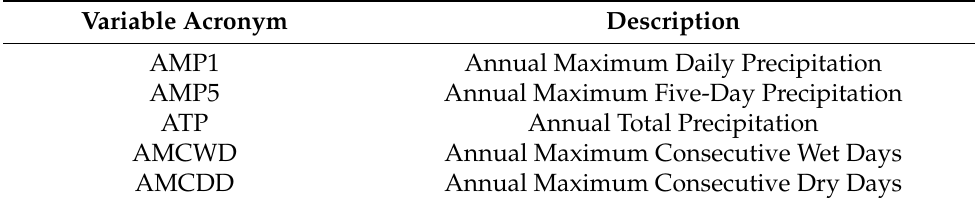
Table 1. The five climate variables considered in this